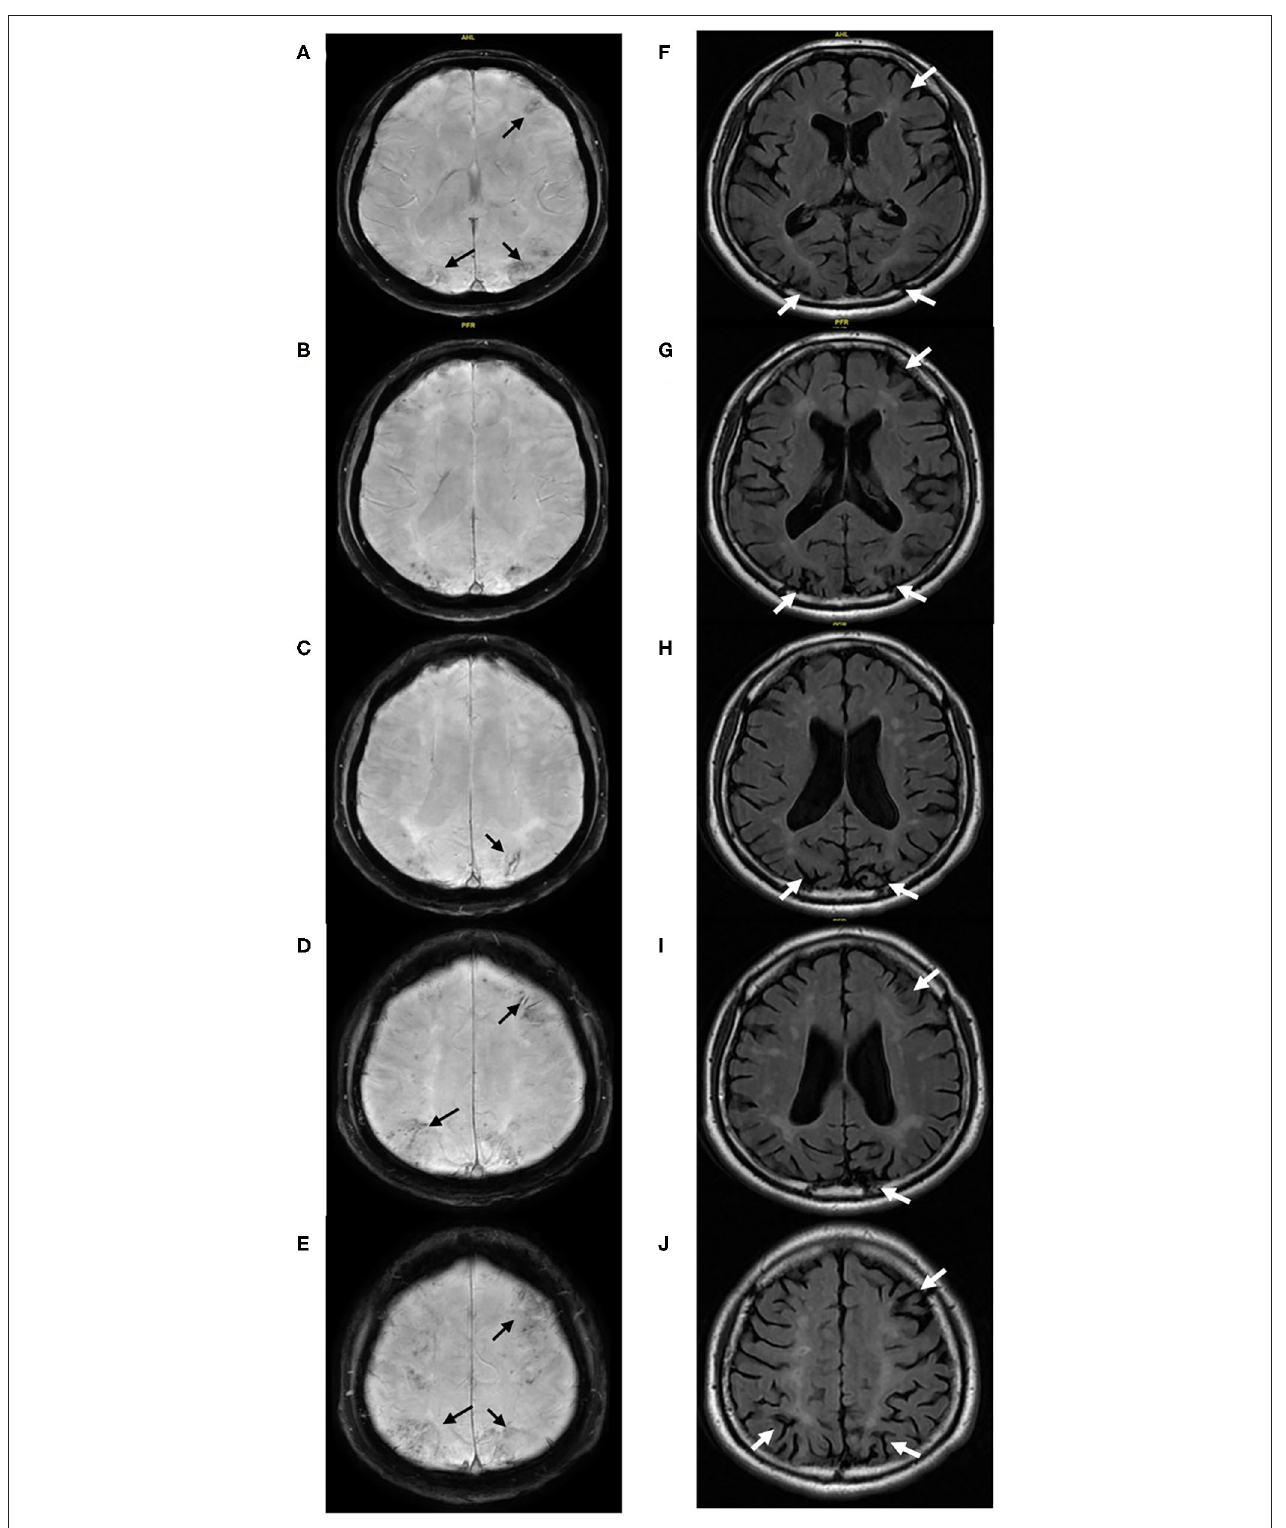
FIGURE 4 | (Case 6) Multiple cerebral microbleeds predominantly restricted in the cortex and chronic superficial siderosis (black arrow) located in the anterior and posterior cortical watersheds are detected on SWI (A–E) . The corresponding cerebral atrophy (white arrow) and associated white matter hyperintensities were found on Flair (F–J)